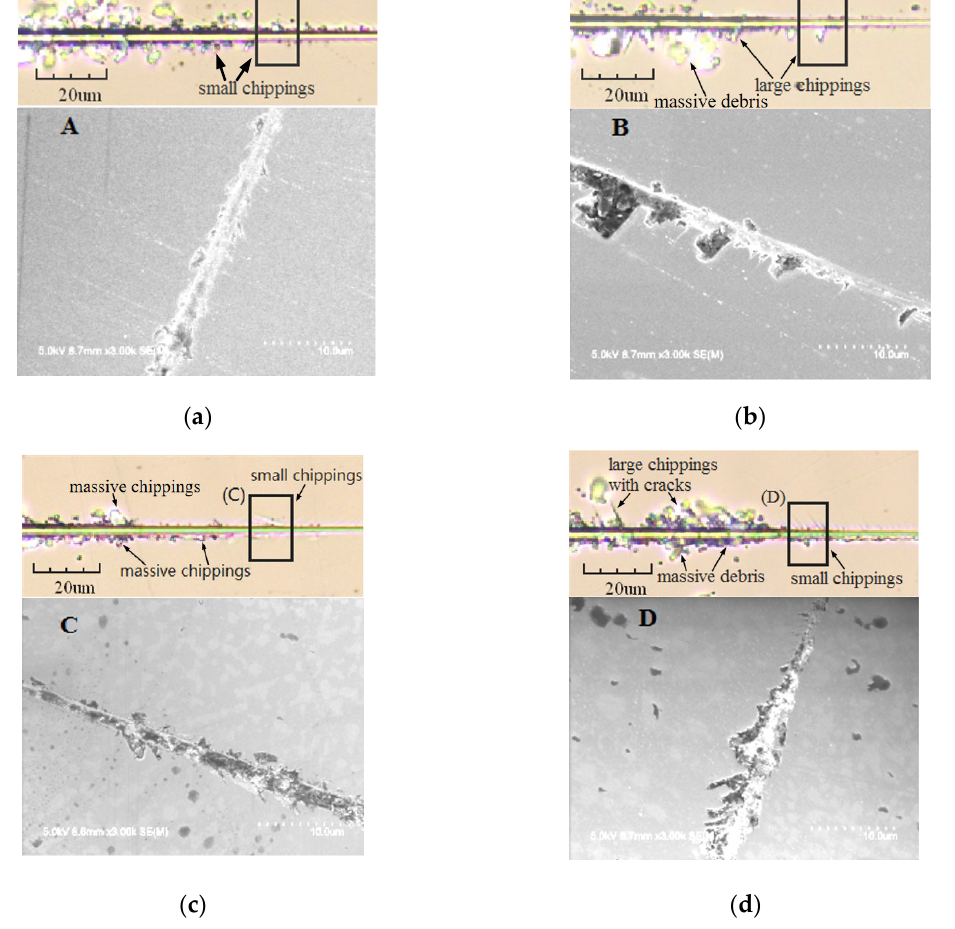
Figure 10. Scratches in suit scanning and SEM part magnification: ( a ) X axis on Z-cut, ( b ) Y axis on Z-cut, ( c ) Y axis on X-cut, ( d ) Z axis on X-cut. Table 1. Brittle-ductile transition critical depth and critical load of different orientations.